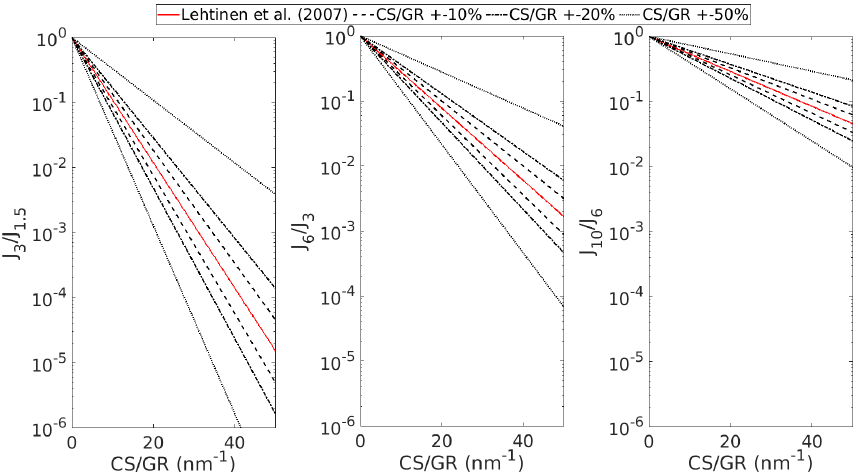
Figure 3. Predictions for the survival probabilities from 1.5 to 3nm ( J 3 /J 1 . 5 ), from 3 to 6nm ( J 6 /J 3 ), and from 6 to 10nm ( J 10 /J 6 ) according to the formulation by Lehtinen et al. (2007). Values with accurate CS / GR are marked with the red line; the black lines correspond to the survival probabilities with CS / GR being 10%, 20%, and 50% lower, or higher, than